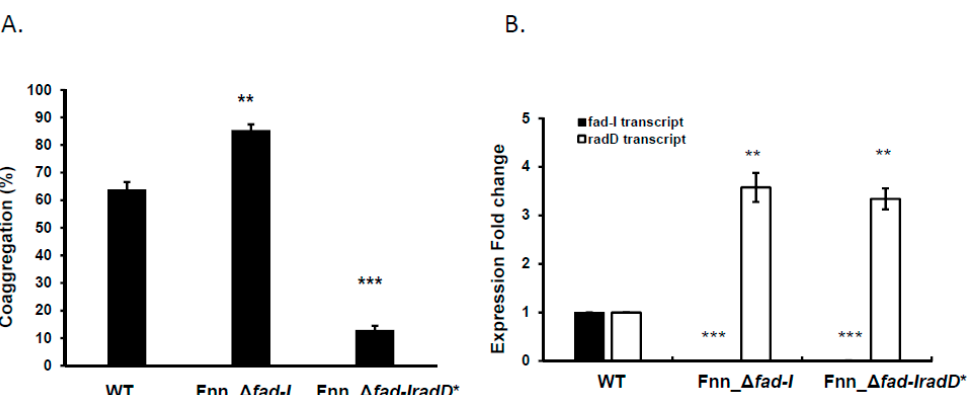
Figure 5. Quantitative coaggregation and transcriptional analysis of F. nucleatum ssp . nucleatum, Fnn _ Δ fad-I , and Fnn _ Δ fad-IradD*. ( A ) Coaggregation of wild-type ATCC 23726 (WT), Fnn _ Δ fad-I, and Fnn_ Δ fad-IradD* with S. gordonii is represented as mean of percentage coaggregation and standard error of mean of three independent experiments. ( B ) fad-I and radD transcript levels are represented as expression fold change compared to the wild-type parent ATCC 23726 . The data represent the mean and standard error of mean of three independent experiments. (** represents p ≤ 0.01 compared to the WT control, *** represents p ≤ 0.001 than the WT).